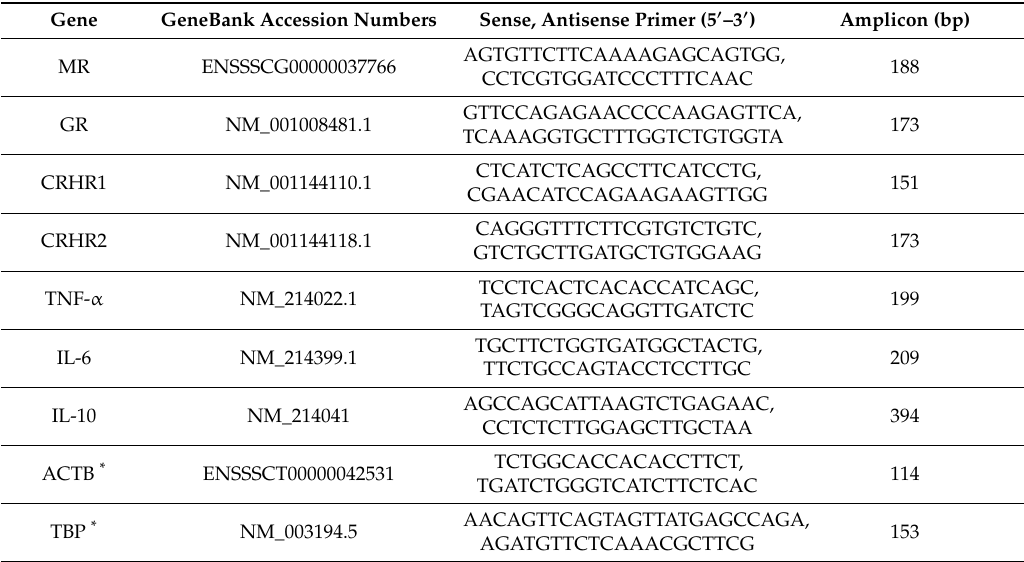
Table 5. Genes, primer sequences and amplicon